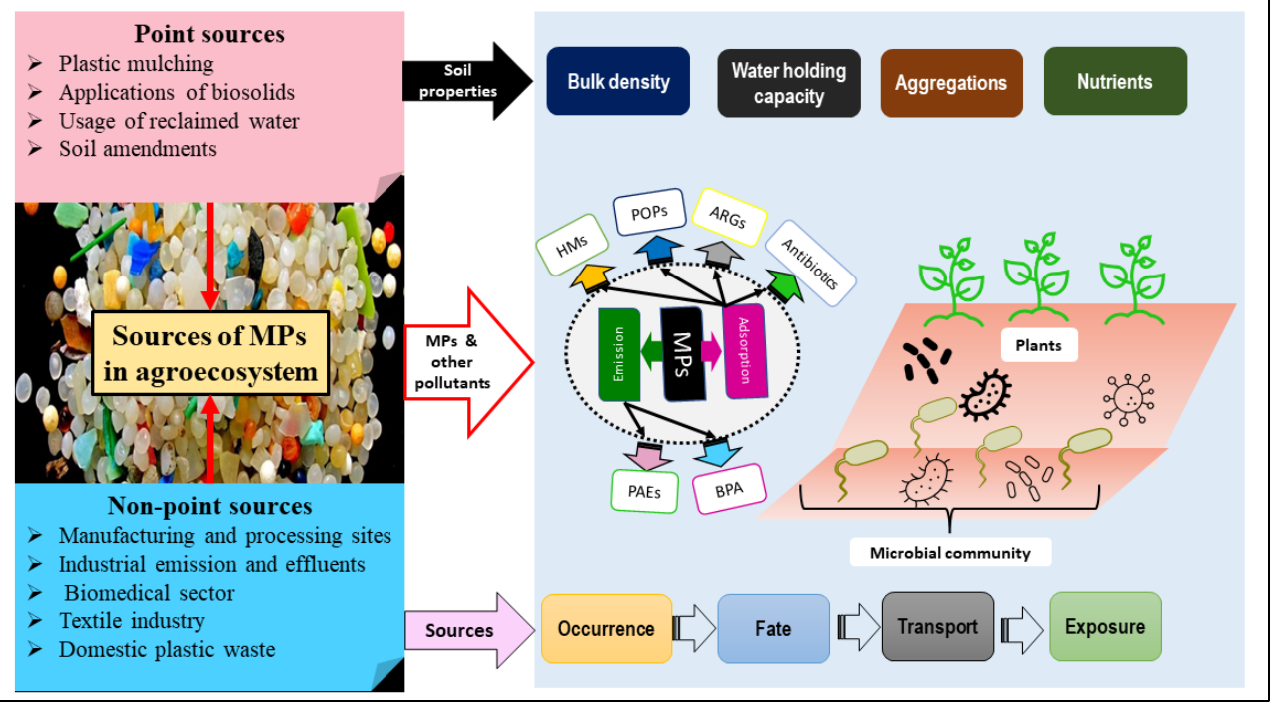
Figure 3. Representation of microplastics sources in the agroecosystems, the impacts on soil prop- erties, and their fate; HM: heavy metal, POPs: persistent organic pollutants, ARG: antibiotics and bacterial/phage resistance genes, PAEs: phthalic acid esters, BPA: bisphenol-A.